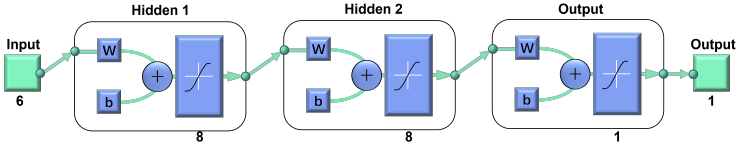
Figure 4. ANN model topology